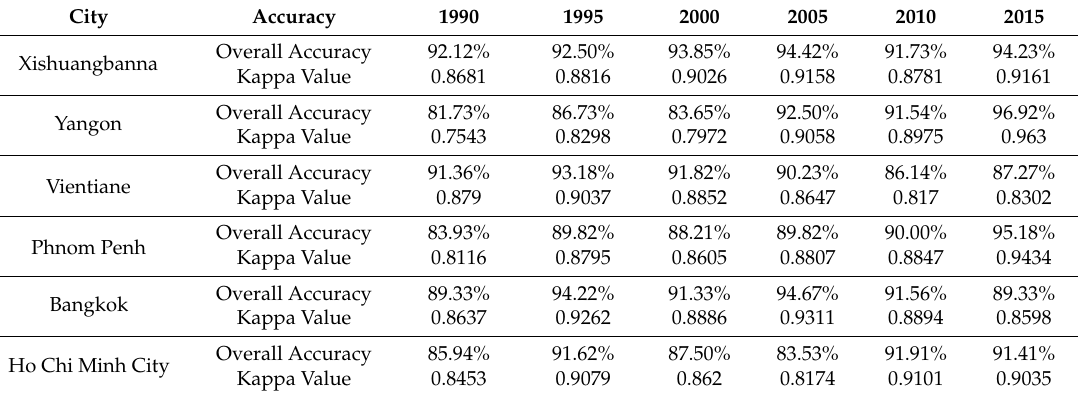
Table 1. Classification accuracy of the typical cities in the Greater Mekong Subregion